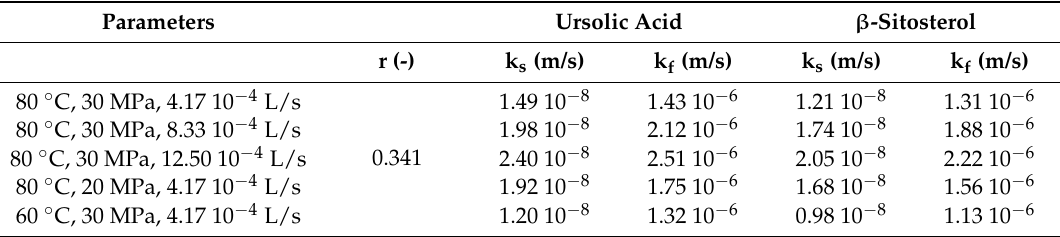
Table 3. The kinetic parameters of broken plus intact cell model obtained for tested process parameters.